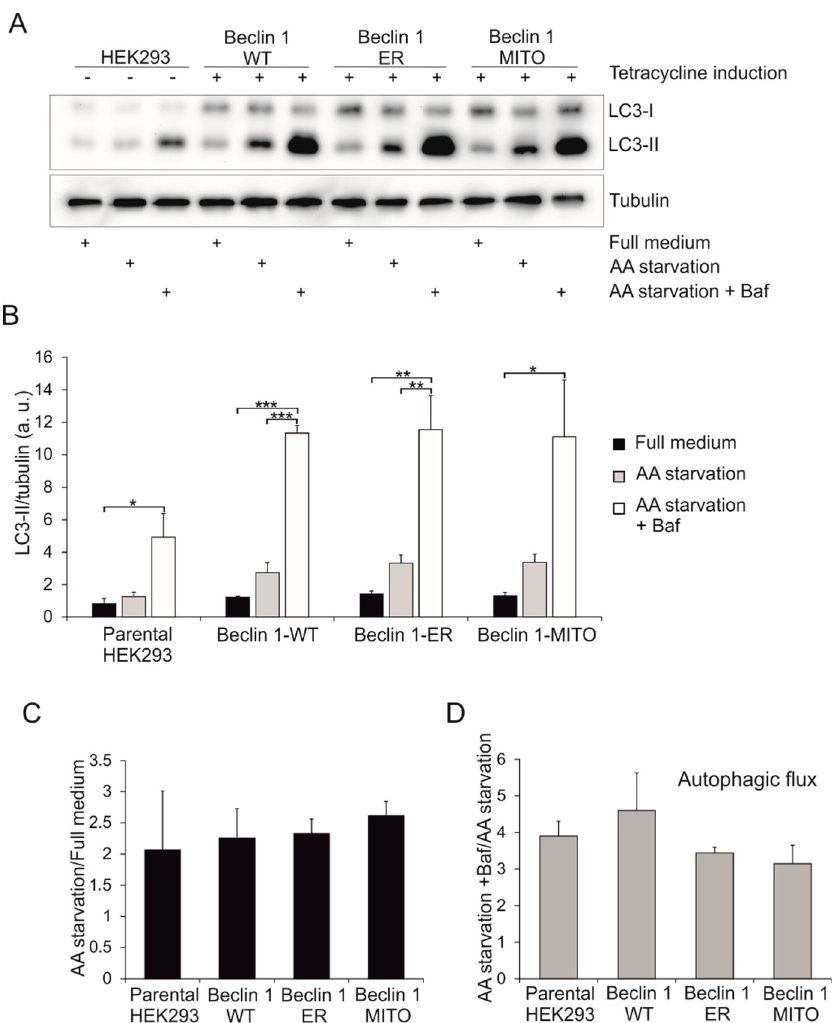
Figure 5. Effect of Beclin 1 constructs on LC3 levels in stable inducible HEK293 cells. HEK293 cells stably expressing Twin-StrepII-HA-tagged Beclin 1 constructs were induced by adding 2 μ g/mL tetracycline to the culture medium for 24 h. Normal HEK293 cells were used as control. Cells were kept in full medium or starved in amino-acid (AA) free medium for 2 h with or without 100 nM bafilomycin A1. ( A ) Cell lysates were analyzed by Western blotting with LC3 antibody. Tubulin was used as loading control. ( B ) Relative LC3-II levels (LC3-II/tubulin). ( C ) LC3-II relative increase during starvation (AA starvation/Full medium). ( D ) Autophagic flux (AA starvation+Baf/AA starvation). Results are shown as mean of three biological replicas (N = 3). Error bars represent SEM. One-way analysis of variance (ANOVA) followed by Tukey Kramer post hoc test was used to assess statistical significance. * p < 0.05, ** p < 0.01, *** p < 0.001.